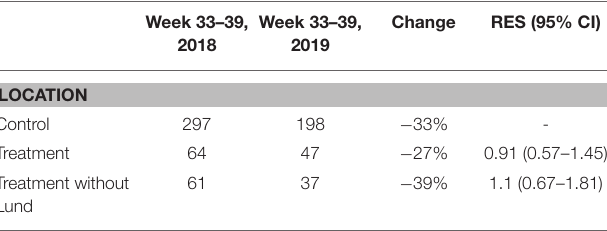
TABLE 1 | Vehicle arsons before/after for treatment and control areas and relative effect size (RES) with 95% confidence